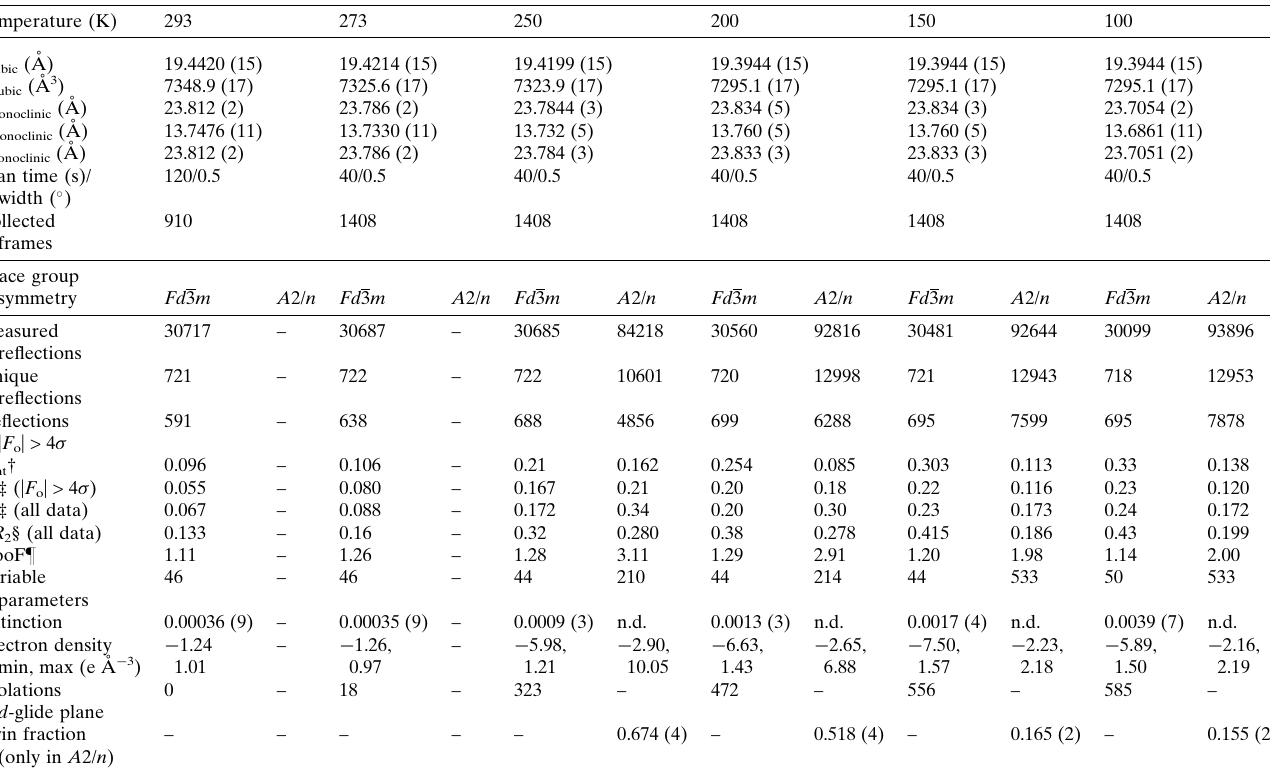
Table 1 X-ray intensity data collections and single-crystal structure refinements of chibaite in the temperature range from 293 to 100 K. Refinements were carried out in the space groups Fd 3 m (No. 227) and A 2/ n (No. 15); (cid:2) monoclinic = 109.47 (cid:3) , a mon = c mon = (a cub /2) (cid:6) 2 1/2 (cid:6) 3 1/2 , b mon = ( a cub /2) (cid:6) 2 1/2 , (cid:2) = 2arctan 2 1/2 = 109.47 (cid:3) , Z cub = Z mon = 136 [SiO 2 (cid:2) x (CH 4 , C 2 H 6 , C 3 H 8 , i -C 4 H 10 , CO 2 ,